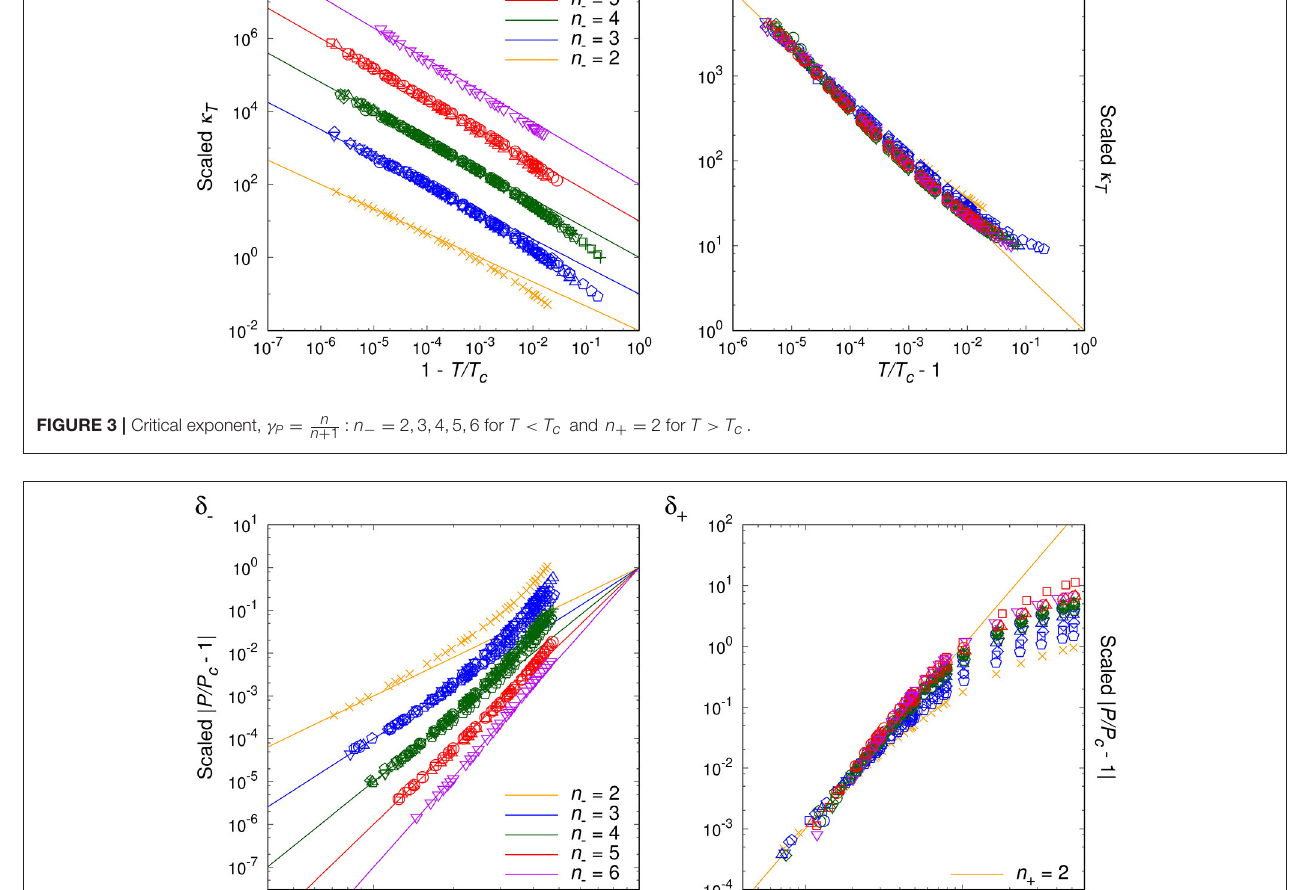
Frontiers in Physics |